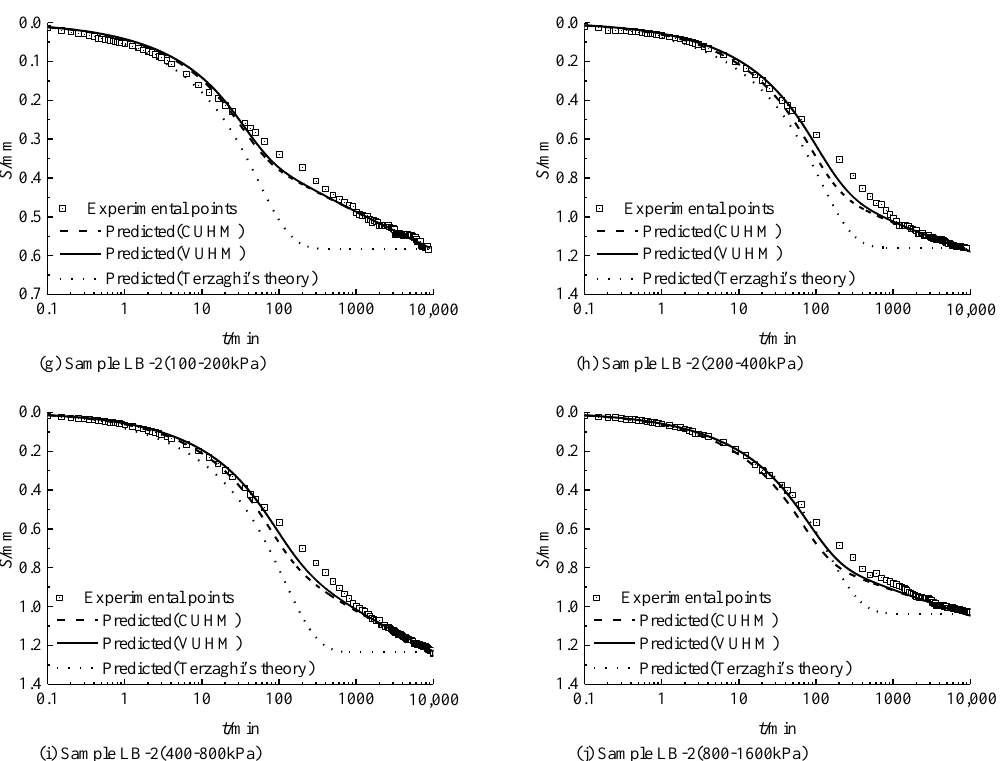
Figure 9. Comparison of theoretical and experimental settlement values for samples LB-1and LB-2. CUHM: unified hardening model with constant permeability coefficient, VUHM: unified hardening model with variable permeability coefficient.